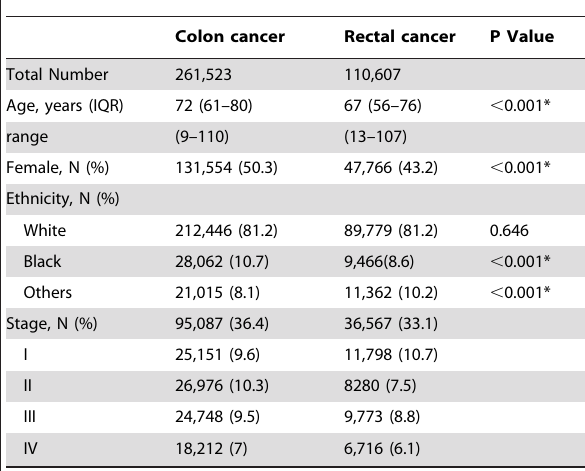
Table 3. Characteristics of the subjects with and without stage information.